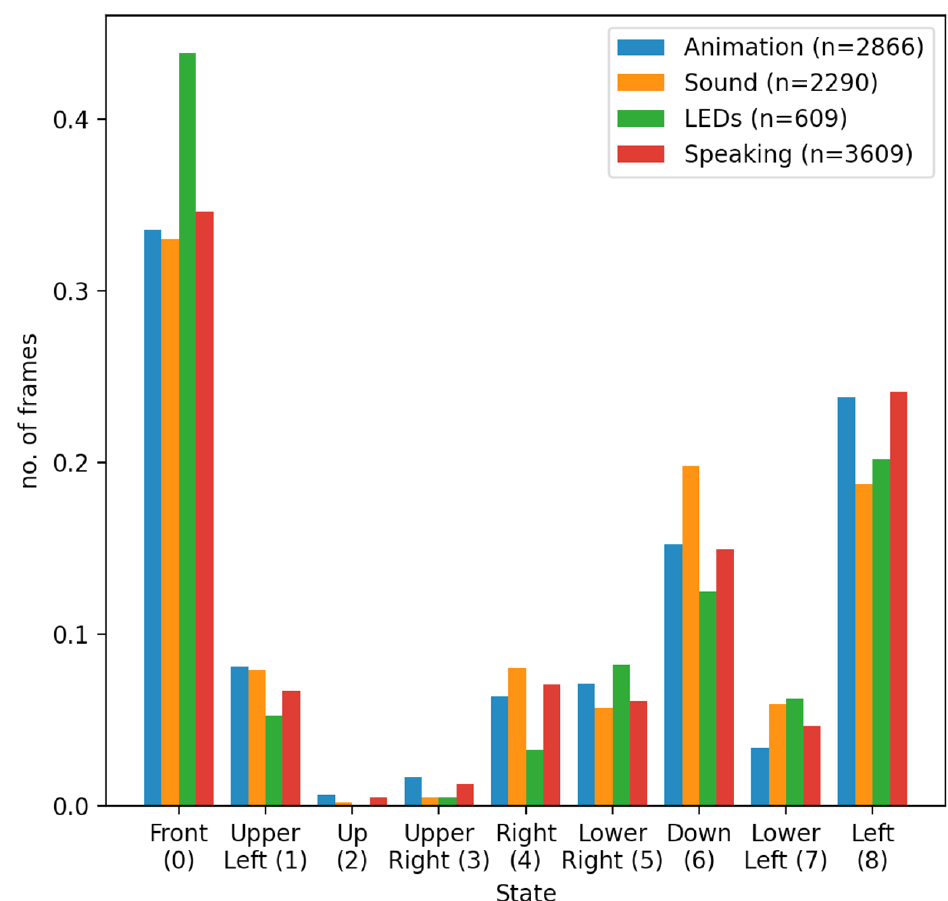
Figure 8. Four normalized distributions of the set of complete frames over the set of nine child states for four different robot modalities, namely Animation, Sound, LEDS and Speaking.